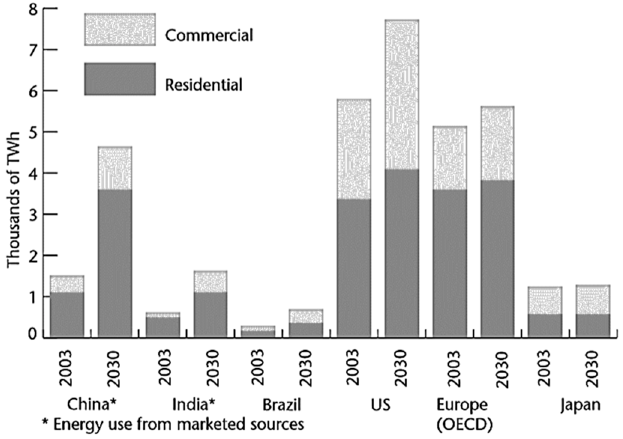
Figure 5. Building energy projection by region 2003–2030 [38].